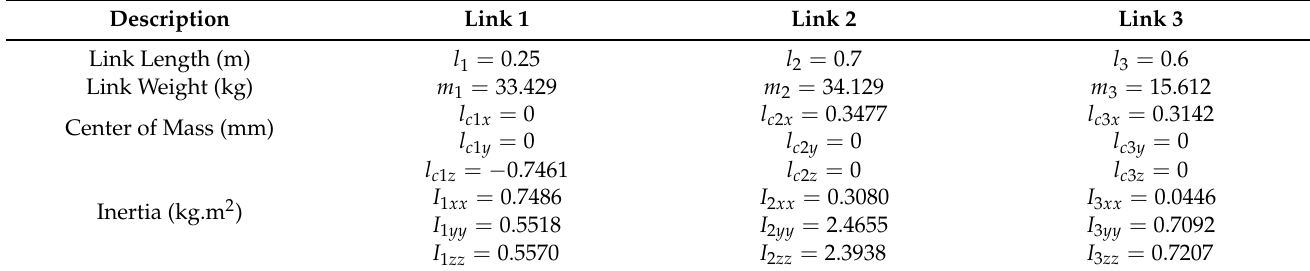
Figure 2. A 3-DoF robotic manipulator is described in a 3D CAD model by utilizing SOLIDWORKS and Simscape Multibody Link. Data from the study [35] were cited for the 3D CAD model of the robot. Table 1. 3-DoF manipulator system